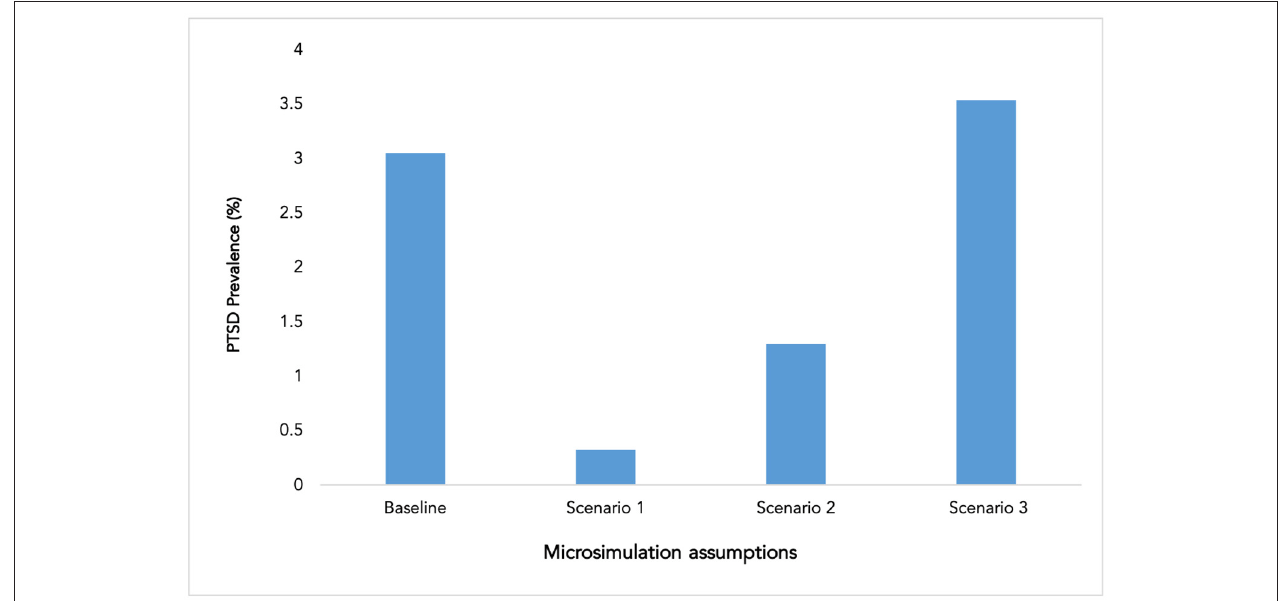
FIGURE 1 | Exposure to television coverage of Parkland mass shooting and post-traumatic stress disorder (PTSD) prevalence. Baseline included a distribution of 11.2% agents watching < 4h, 13.1% watching between 4–7h, 10.8% watching between 8–11h, and 64.9% watching 12h or more. Scenario 1: agents watched television < 4h per day. Scenario 2: all agent preferences were shifted to the lower half of population television watching distribution (i.e., all agents either watched 4 or less h or 4–7h of television coverage). Scenario 3: all agent preferences were shifted to the upper half of population television watching distribution (i.e., all agents ether watched 8–11h 12 or more hours of television coverage).